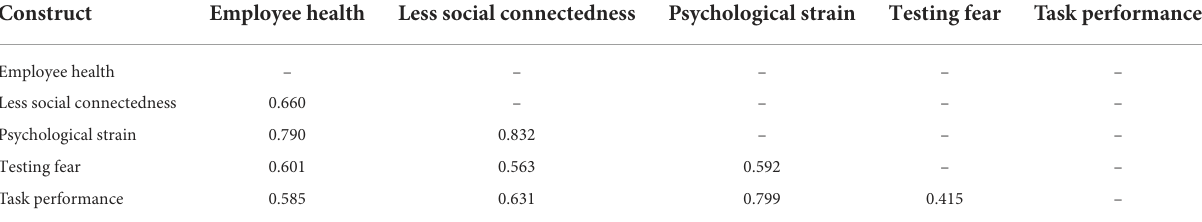
TABLE 3 Discriminant validity